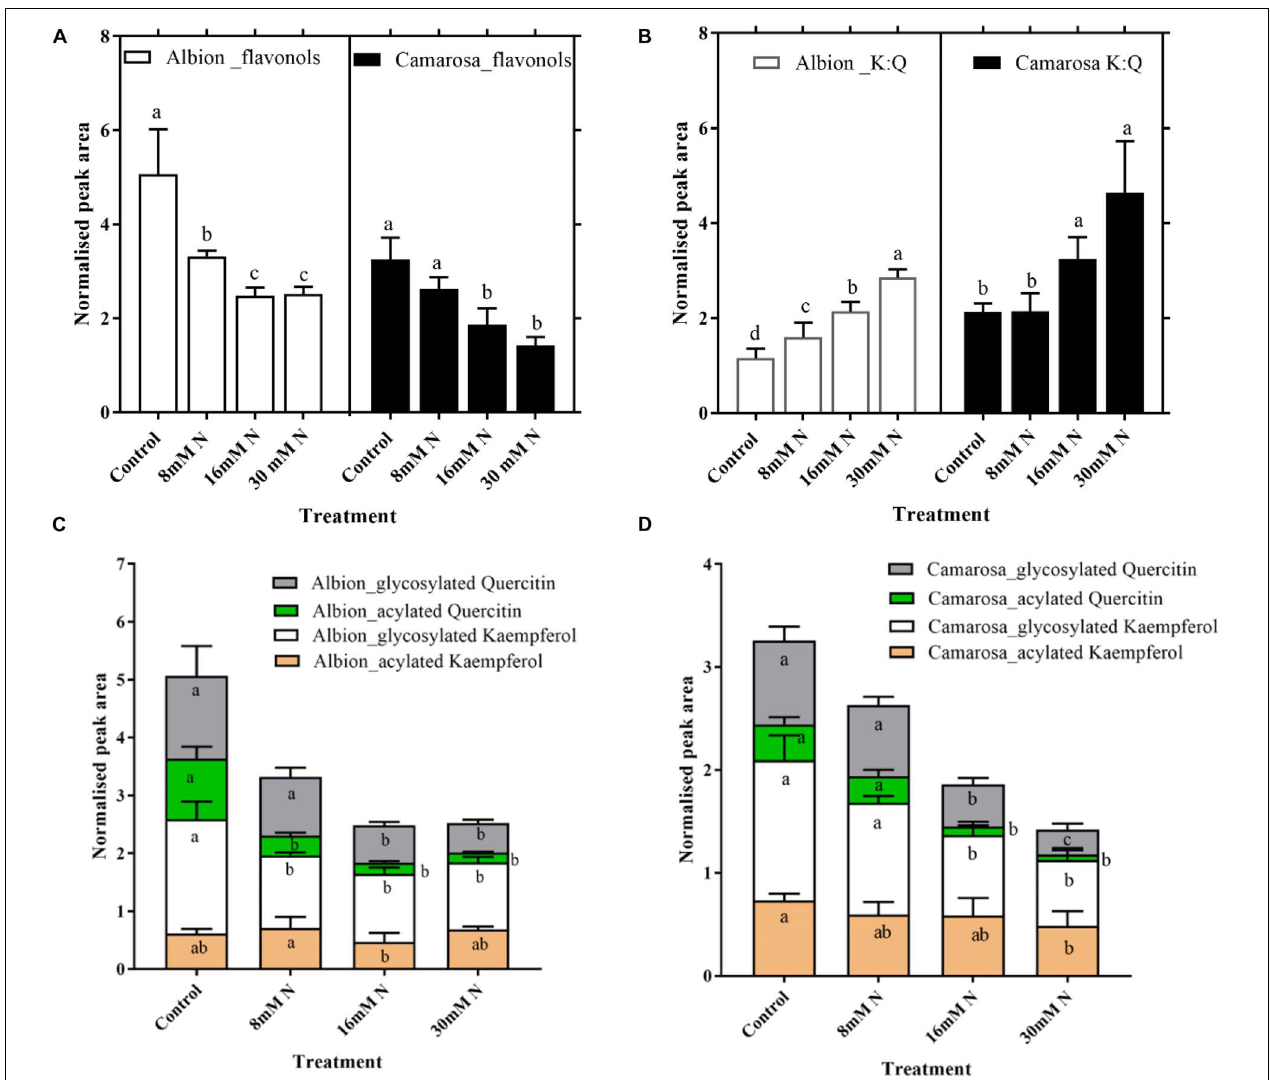
FIGURE 7 | Abundances of flavonols (A) and kaempferol:quercetin ratio (B) and different structural modifications of kaempferol and quercetin in Fragaria ananassa cv. Albion (C) and cv. Camarosa (D) exposed to four N treatments. The data represent the mean ± SD ( n = 5) 13 C resveratrol (1 ng) normalized abundance and were tested by one-way ANOVA with Tukey’s honestly significant difference (HSD). Bars with the same letters are not significantly different at the 95% confidence